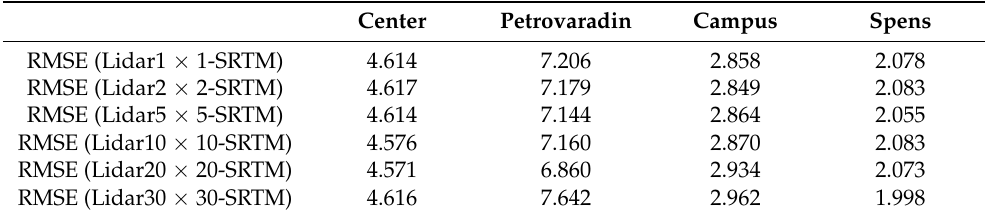
Table 1. Calculated RMSE values.